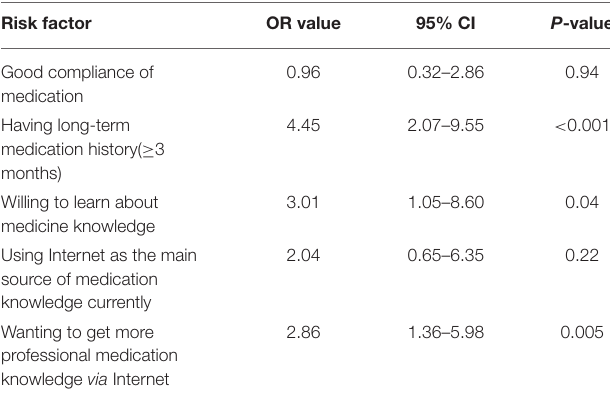
TABLE 4 | Multi-variate analysis of influencing factors associated with the willingness to install and use MTM applications. Risk